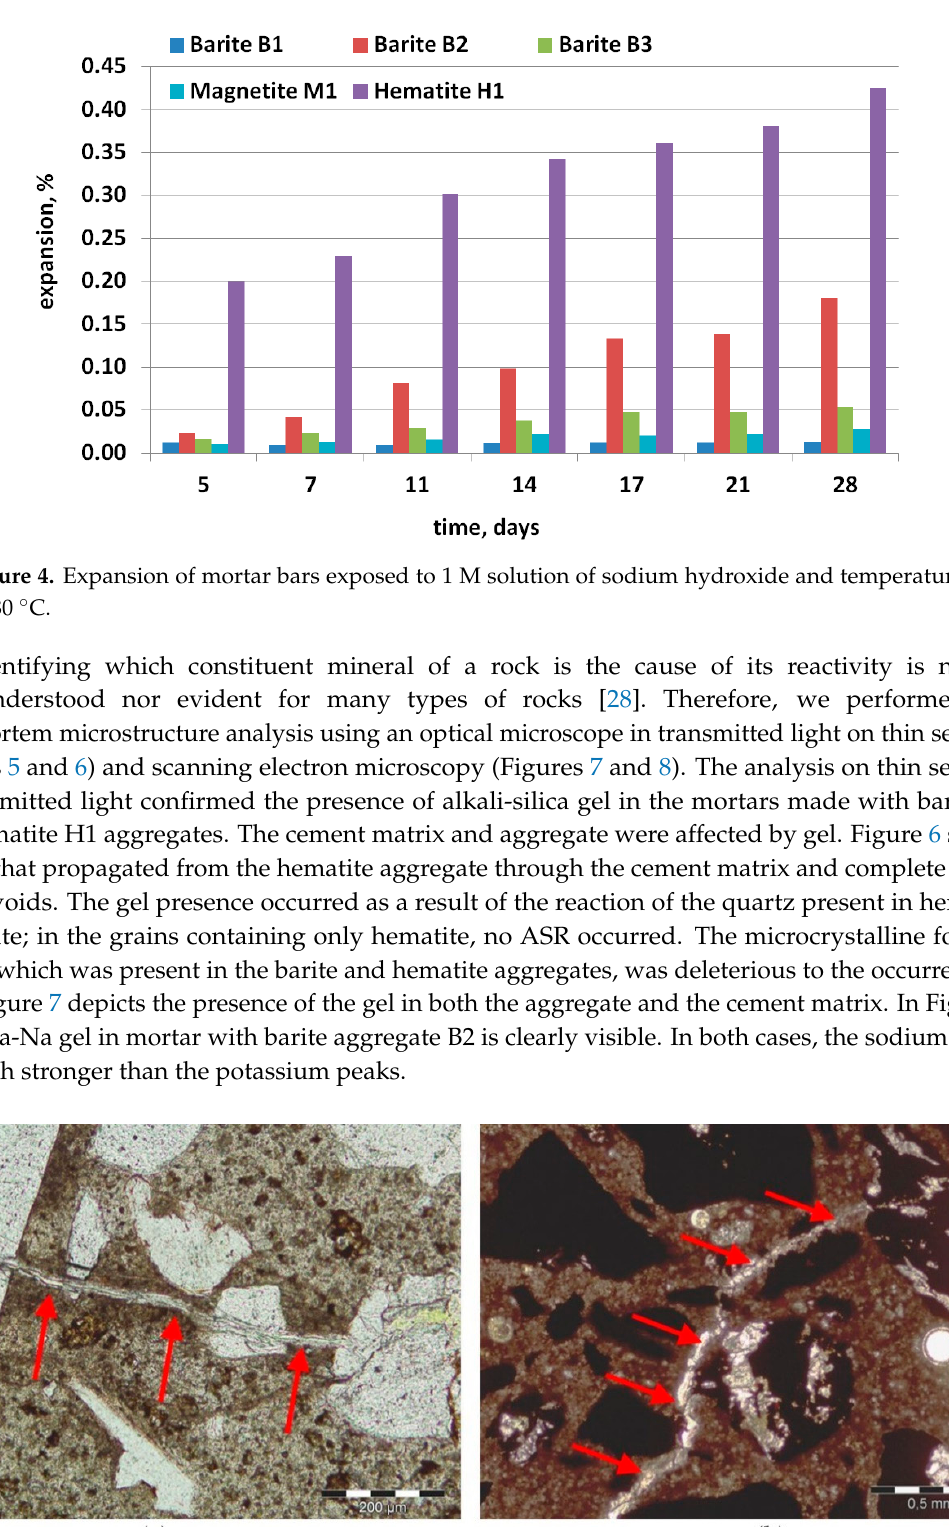
Figure 6. Post-mortem analysis on thin section, mortar with hematite H1: ( a ) PPL; ( b ) XPL_G; 1-hematite grains, 2-air-void filled by gel; scale bar = 200 μ m.